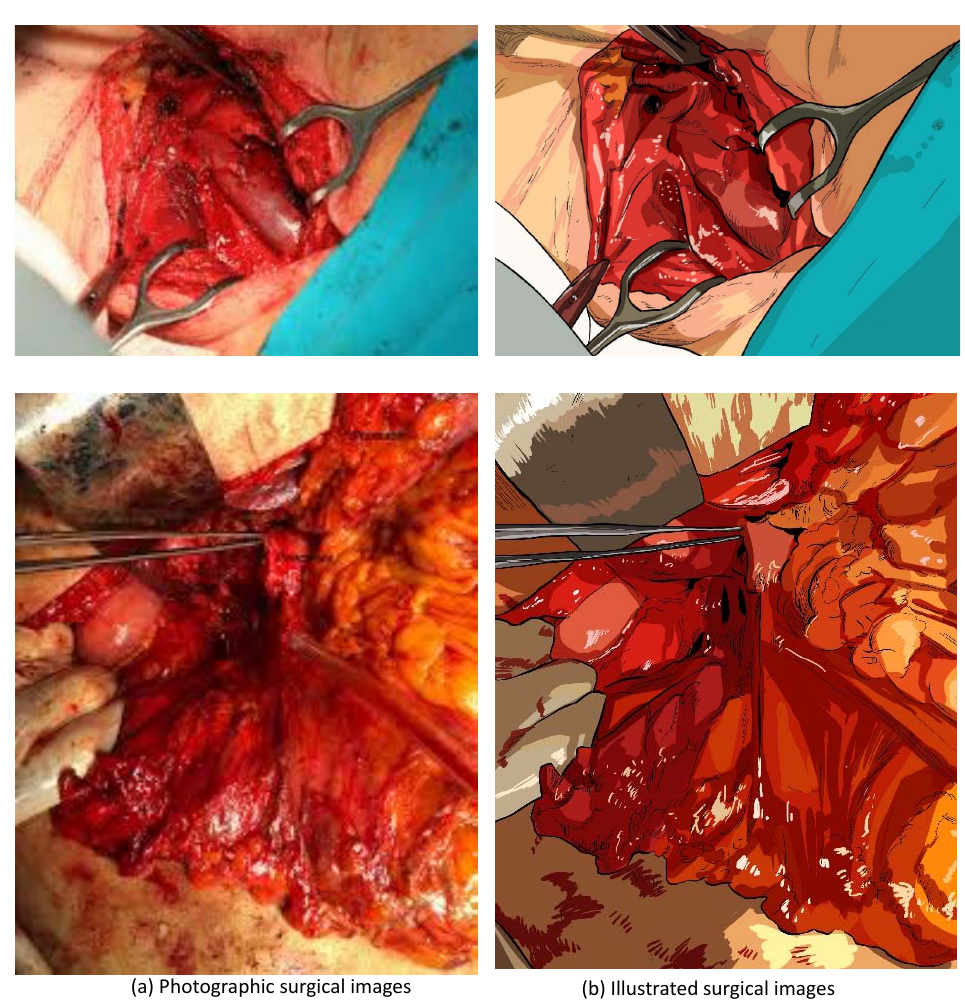
Figure 3. The third comparison of photographic surgical images and illustrated surgical